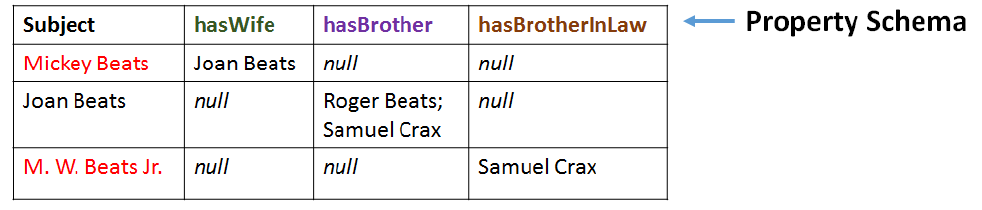
Figure 5. Property table representation of Dataset 1 in Figure